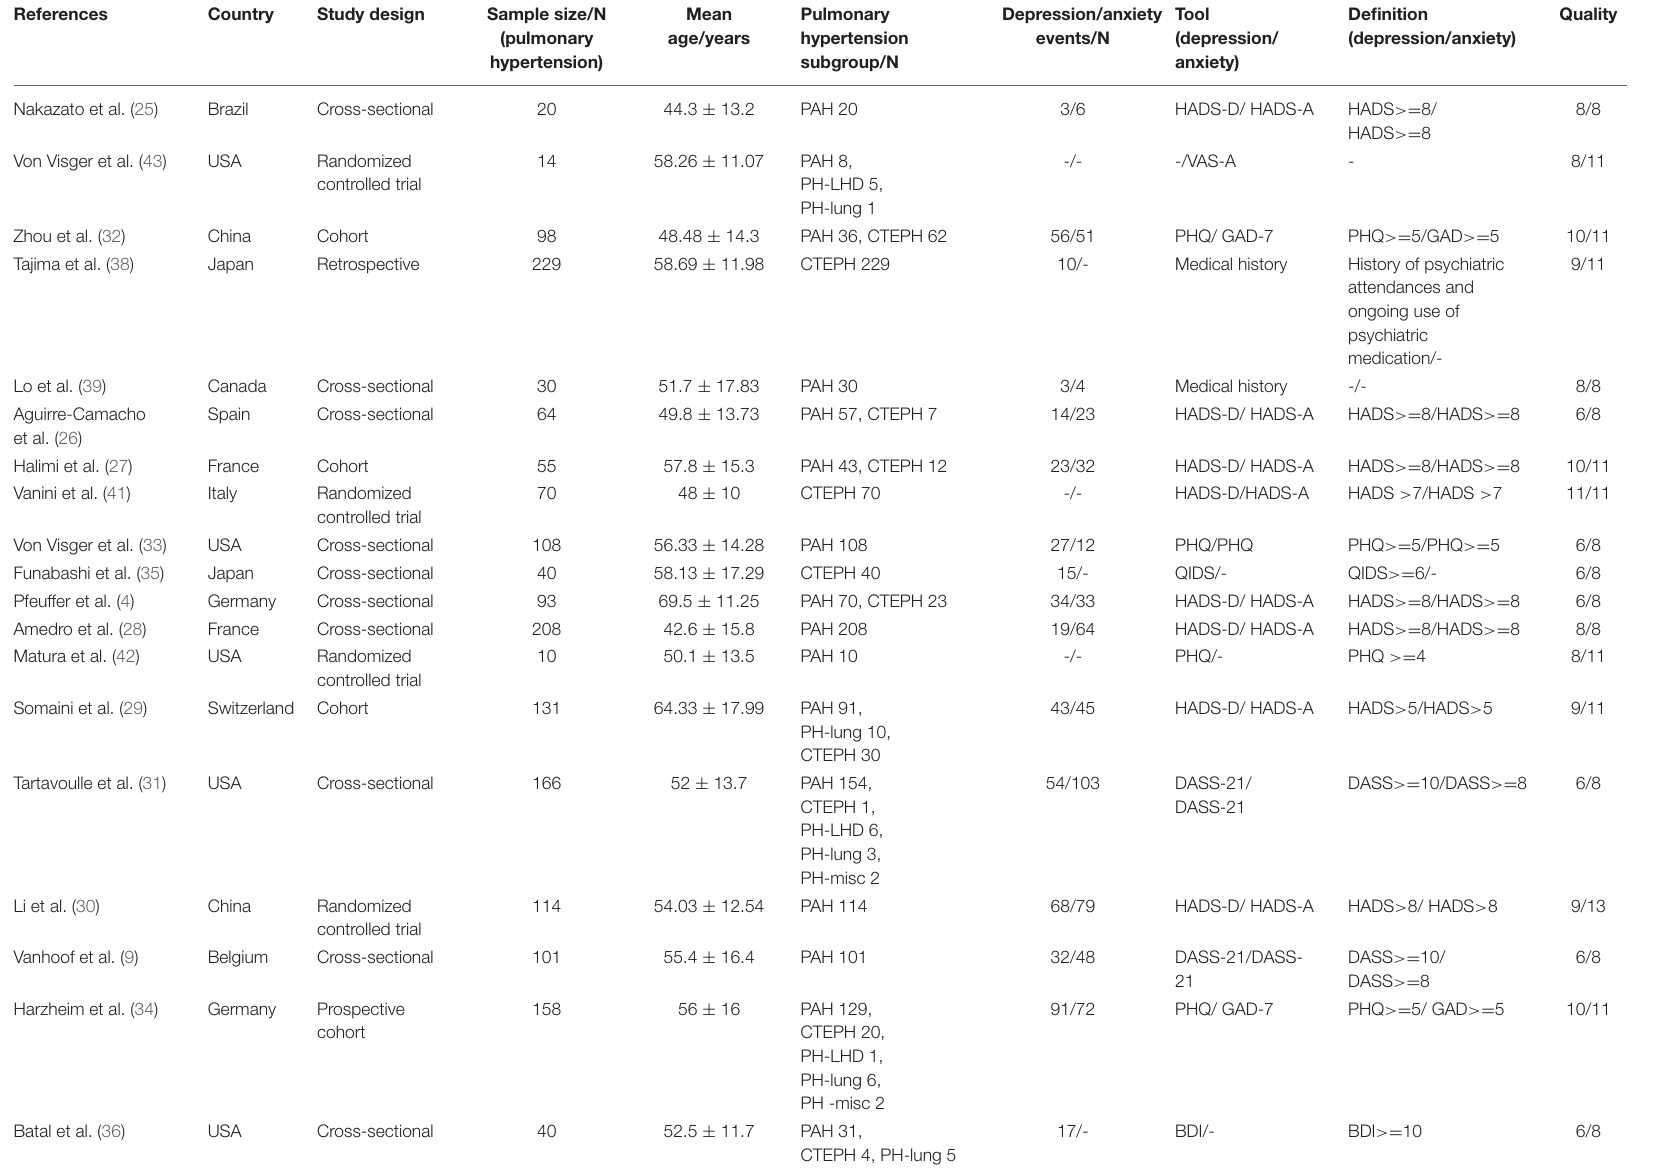
TABLE 1 | Summary of included